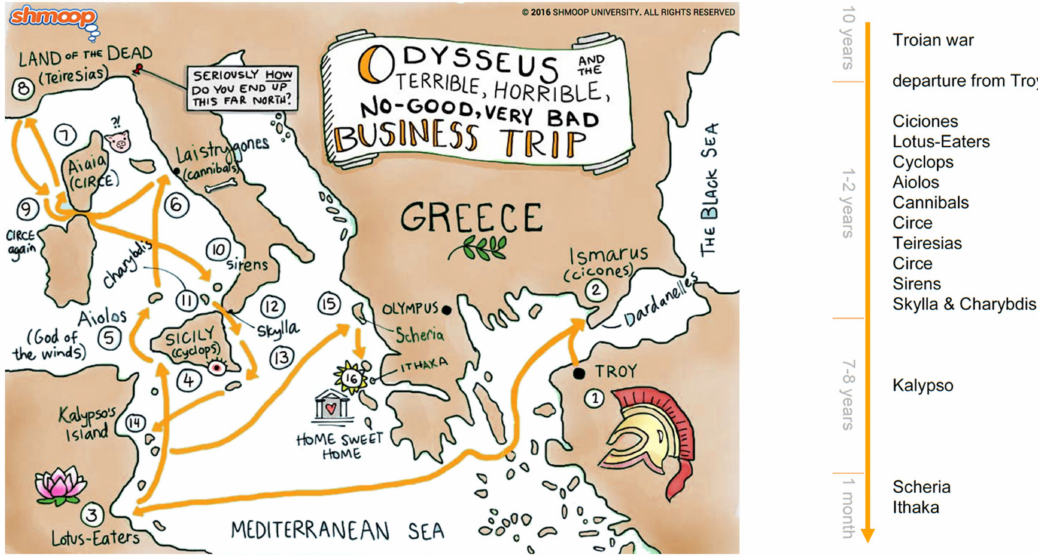
Figure 1. Homer’s Odyssey visualized on a map (adapted from [1]) and as a